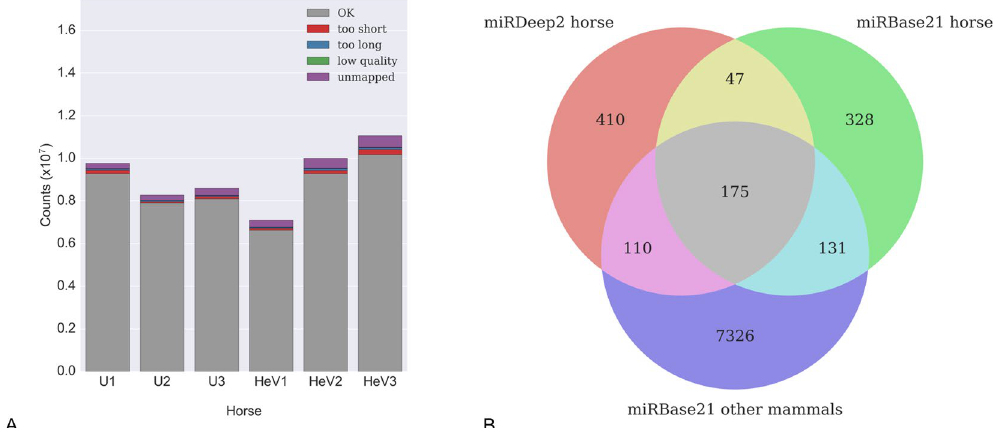
Figure 1. ( A ) Quality control and filtering of raw reads from samples analyzed in this study. U1, U2 and U3 refer to samples derived from uninfected horses, while HeV1, HeV2 and HeV3 refer to samples from HeV-infected horses listed in Table 1. Unique read counts per sample were: U1:26207, U2:25007, U3:38479, HeV1:32102, HeV2:50257, HeV3:64798. ( B ) Comparison between horse miRNAs sequenced in this study (miRDeep2 horse) and reference miRNAs from miRBase21 (miRBase21 horse, miRBase21 other mammals). The majority (410) of miRNAs detected in horse blood were unique from miRNAs listed in miRBase, whilst 332 candidates matched miRNAs cataloged in miRBase.